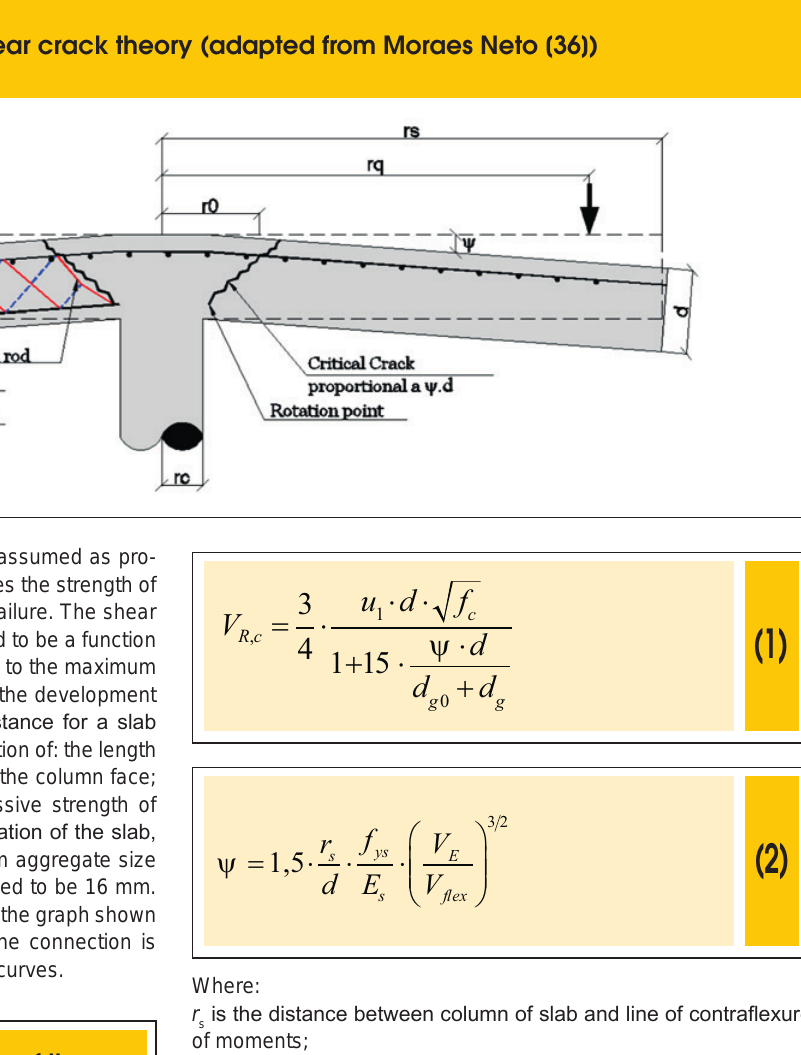
Figure 3 – Graphic representation of the punching strength determination